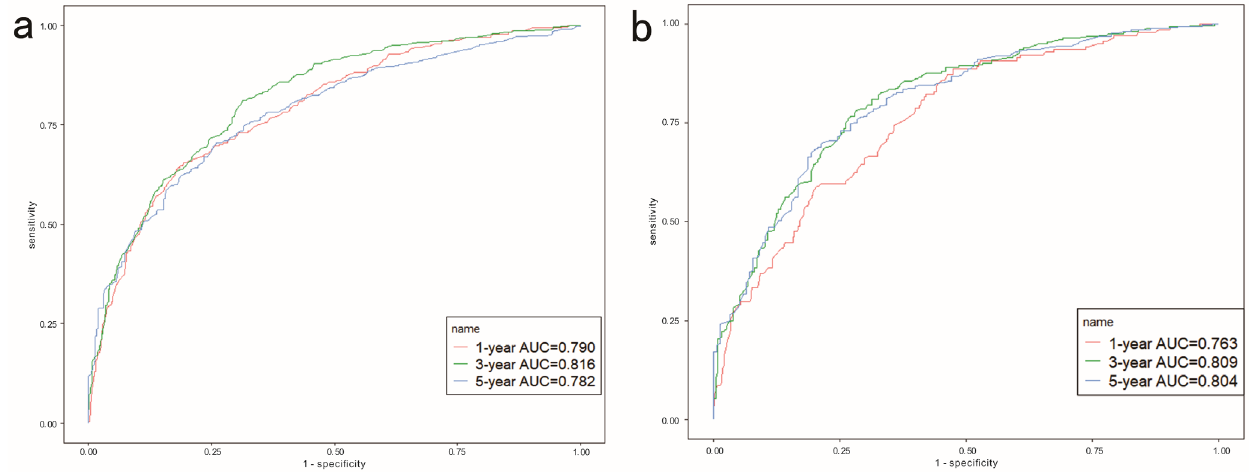
Figure 4. The area under the receiver operating characteristic curve (AUROC) of the model in predicting 1-, 3-, and 5-year overall survival (OS) in the training cohort ( a ) and 1-, 3-, and 5-year OS in the validation cohort ( b ). Table 5. Prognostic efficiency of the nomogram of